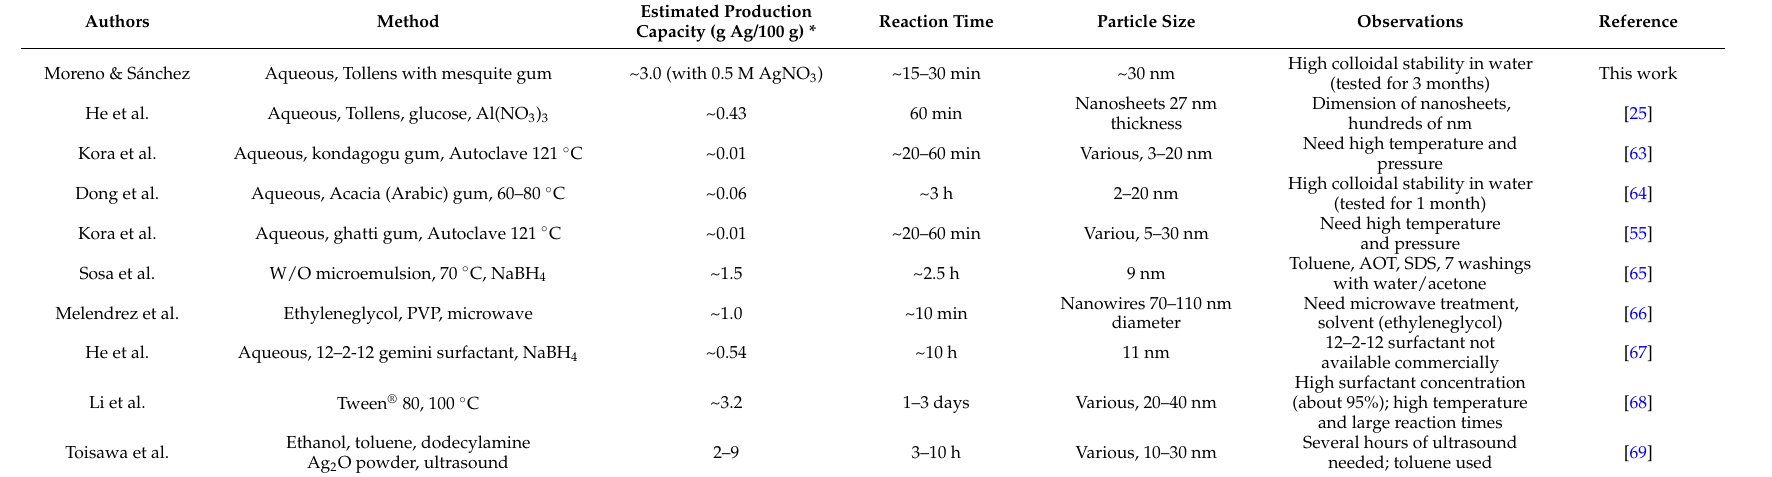
Table 5. Comparison of the estimated production capacity for several methods of Ag nanoparticle synthesis reported in the literature and the method reported